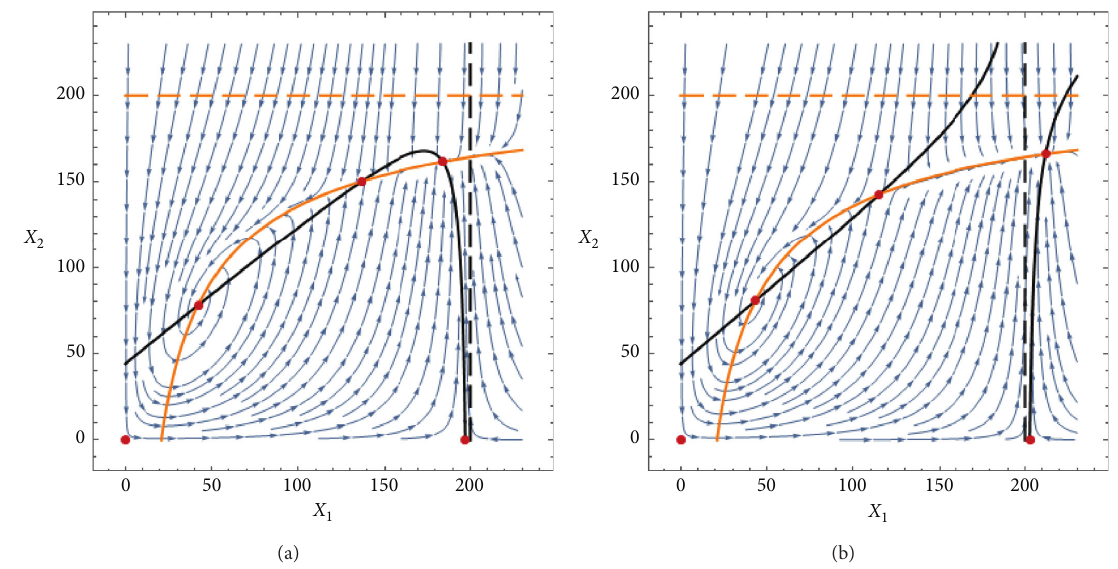
Figure 2: Nullclines and phase space for an antagonistic system where both populations cooperate intraspecifically. Dashed lines represent X � 1/ c i i , and while solid lines are the nullclines (orange for lines inside the rectangle do not point out of this region. (b) a